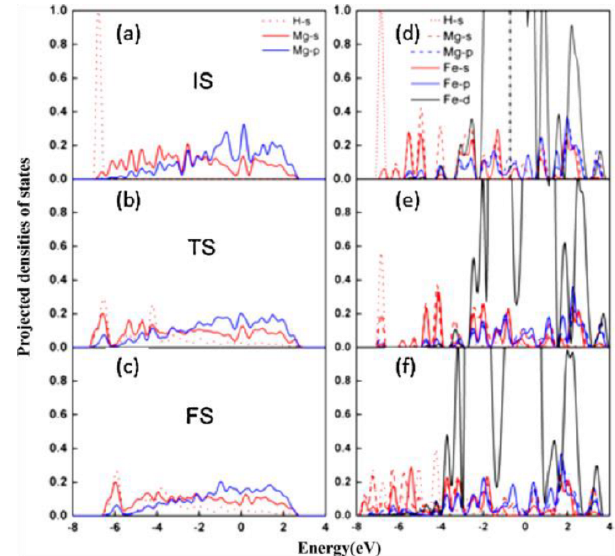
Figure 26. Projected densities of states for H 2 dissociating over a pure Mg(0001) surface as a function of the energy relative to the Fermi level for the ( a ) IS, ( b ) TS, and ( c ) FS. The same is shown for the Fe-doped Mg(0001) surface (Fe is placed in the subsurface) for the ( d ) IS, ( e ) TS, and ( f ) FS. The dashed vertical line shows the position of the d band center in ( d ). ( a – f ) Reproduced with permission [204]. Copyright 2014,